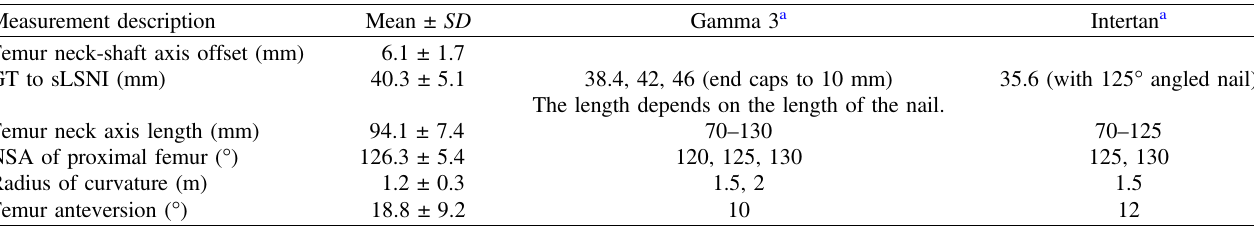
Table 2. Anatomical measurements from the present study compared to the cephalomedullary nail designs parameters of the Stryker Gamma 3 Nail (Kalamazoo, Michigan, USA) [6] and the Smith and Nephew Intertan (Watford, UK) [5].